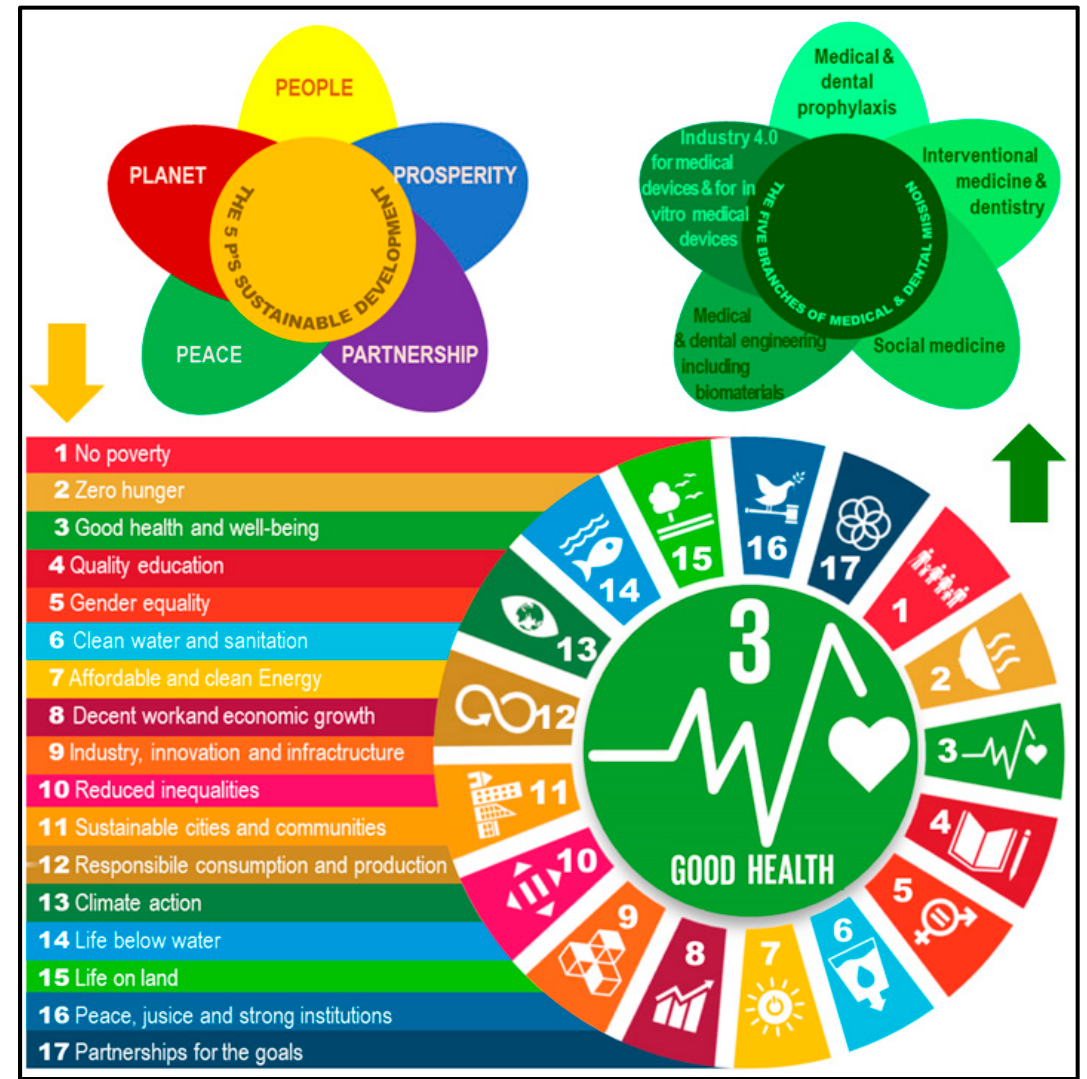
Figure 1. Diagram of five general assumptions of sustainable humanity development at the present stage with the resulting seventeen Sustainable Development Goals established by the United Nations and the resulting five branches of the medical and dental